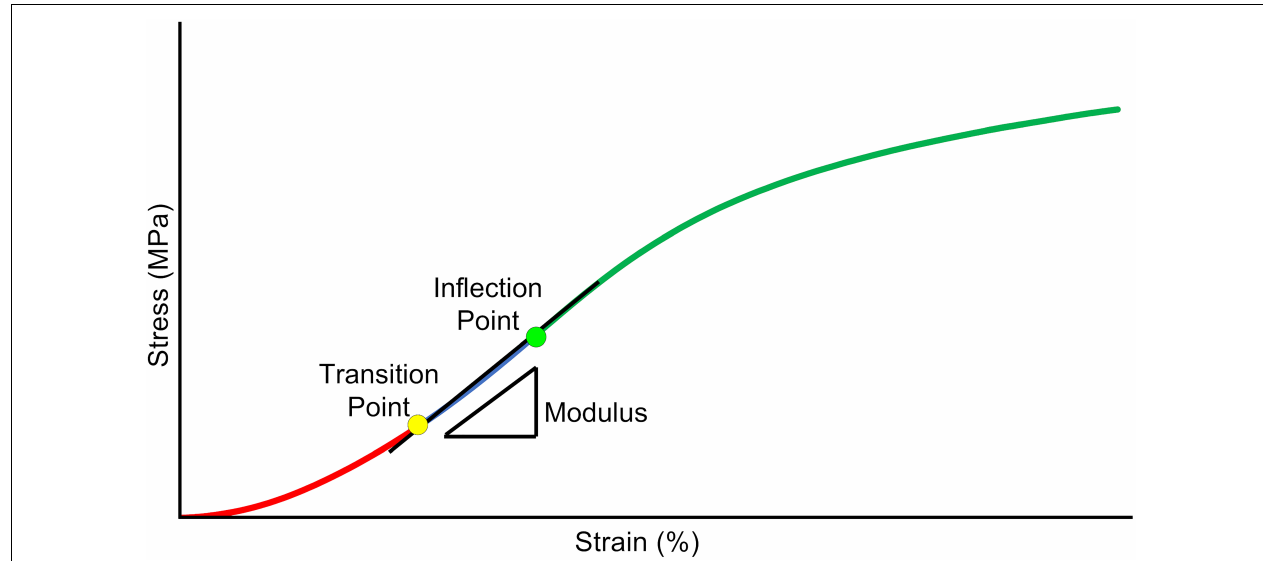
FIGURE 3 | Schematic of critical data derived from the Tanaka et al. (2011) analysis of the low-strain portion of the stress-strain curve. Inflection point, is where the curve transitions from stiffening to softening. Transition point, is where the curve transitions from an exponential curve to a linear curve. Modulus, is the slope of the curve between the transition and inflection